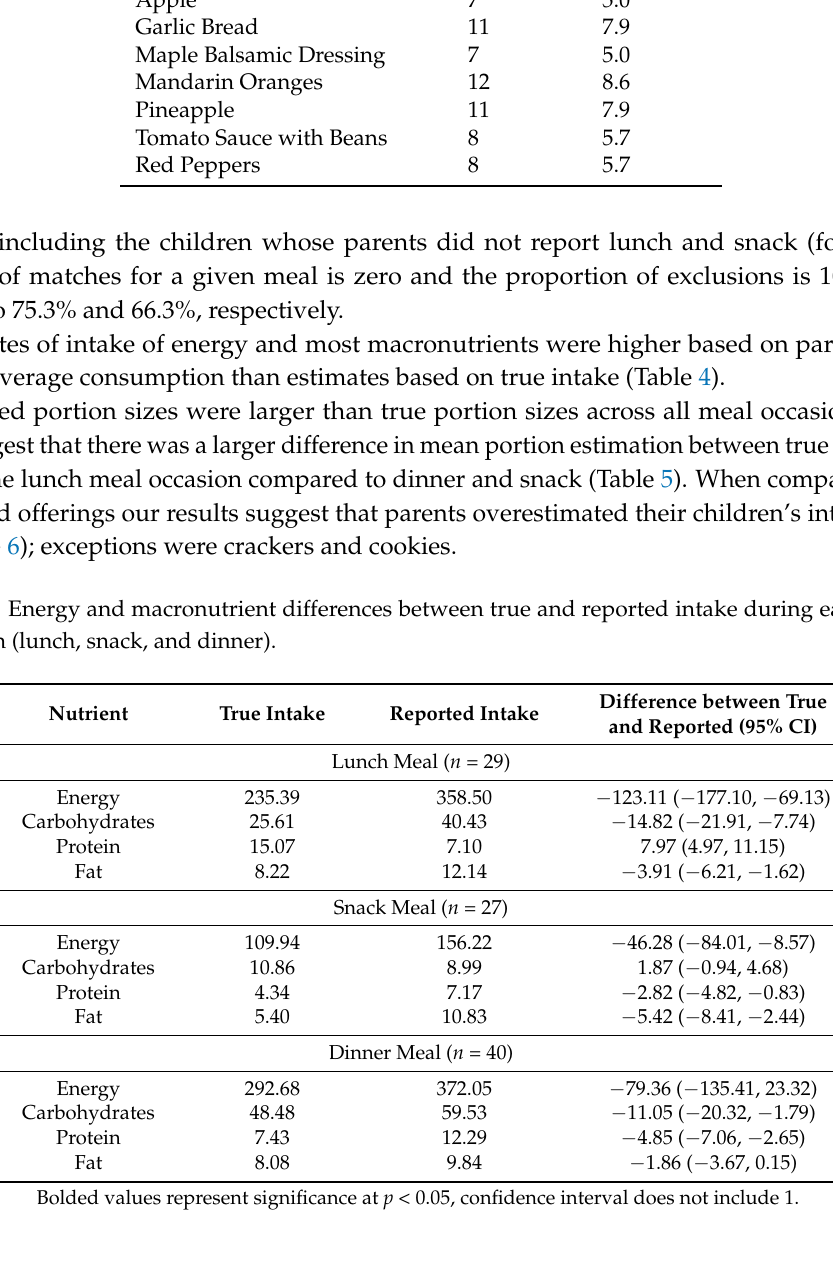
Table 5. Mean portion intake (g) based on true and recalled intakes by meal